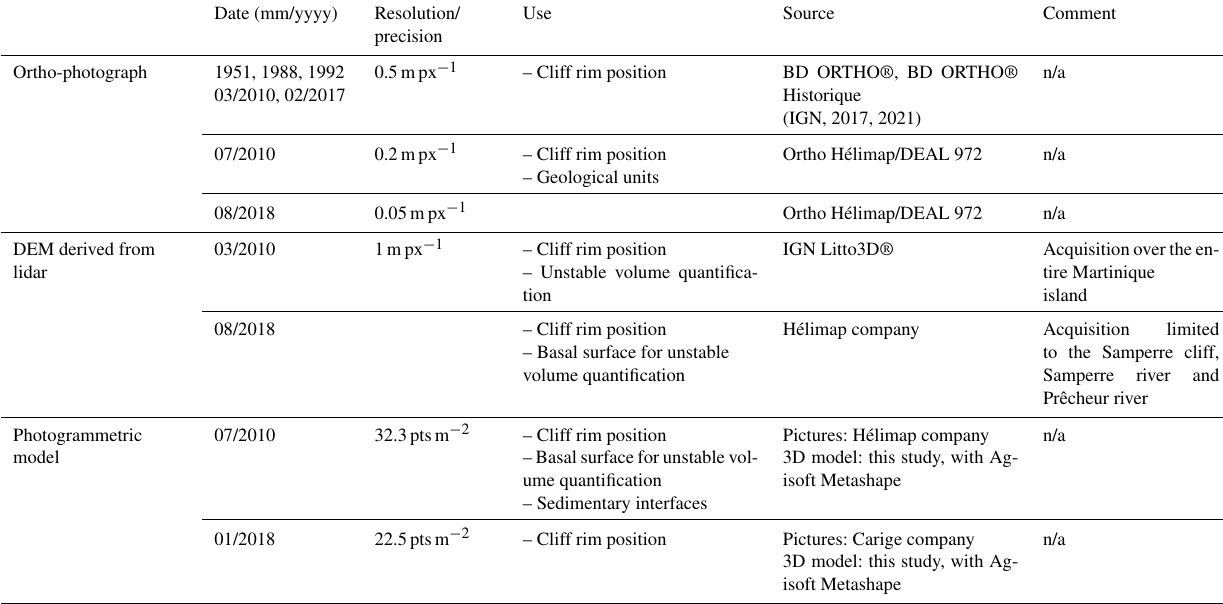
Table 1. Ortho-photographs and topographic surveys. n/a: not applicable. Date